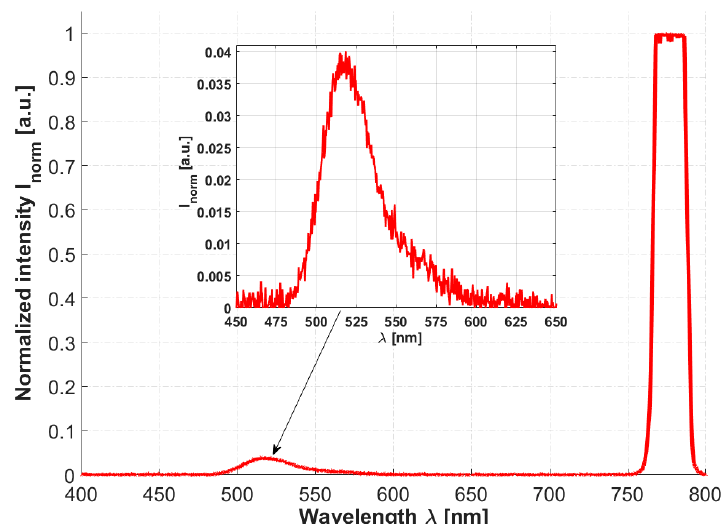
Figure 5. Two-photon excited fluorescence (TPEF) emission spectrum of 10 − 2 M NaOH fluorescein solution (concentration C fluo ≈ 10 − 5 M). A fluorescence peak, visible on the enlarged inset graph, exhibits its maximum at ~518 nm. A backscattered excitation signal peak at 780 nm is also visible, and even though it exceeds the Y-axis maximum, it does not saturate the spectrometer’s detector, and in turn has no influence on the recorded fluorescence spectrum.